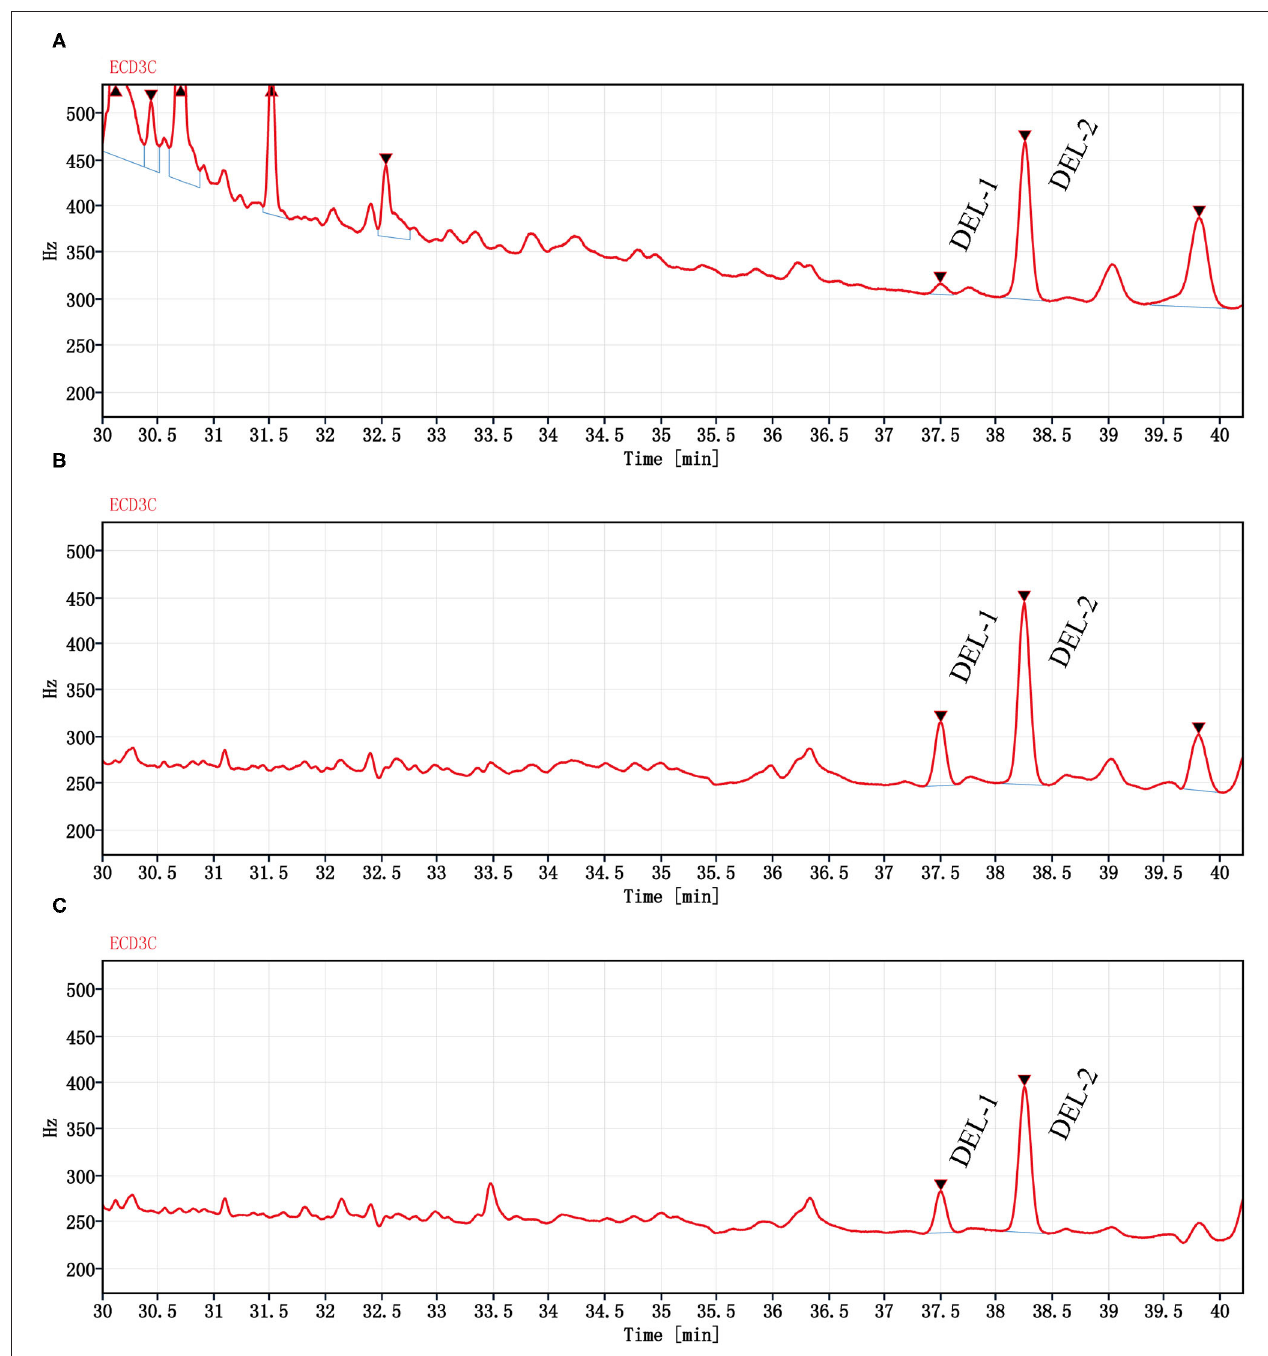
FIGURE 3 | Chromatograms (GC-ECD) of DEL from oyster meat with different processing methods. Chromatograms of DEL are separately in (A) Raw oyster; (B) Steamed oyster; and (C) Roasted oyster. DEL retention time was 37.5 (DEL-1) and 38.2min (DEL-2). Peak areas of DEL-1 and DEL-2 were 85.4 and 1,280 for raw oysters, 483 and 1,480 for steamed oysters, and 312 and 1,210 for roasted oysters,